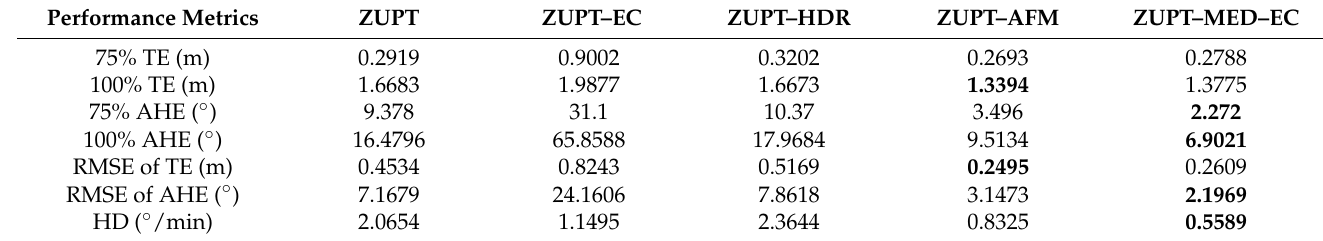
Table 3. Performance of different frameworks on the Vicon dataset. Each bold number refers to the optimal performance in each row.